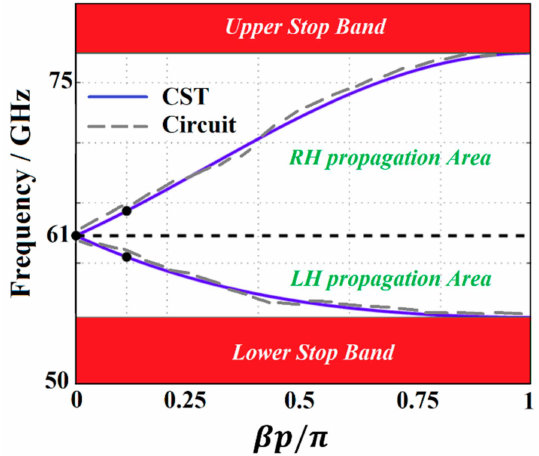
Figure 10. Dispersion diagrams for the proposed LWA array based on SIW-MTM extracted by CST Microwave Studio package and the corresponding equivalent circuit shown in Figure